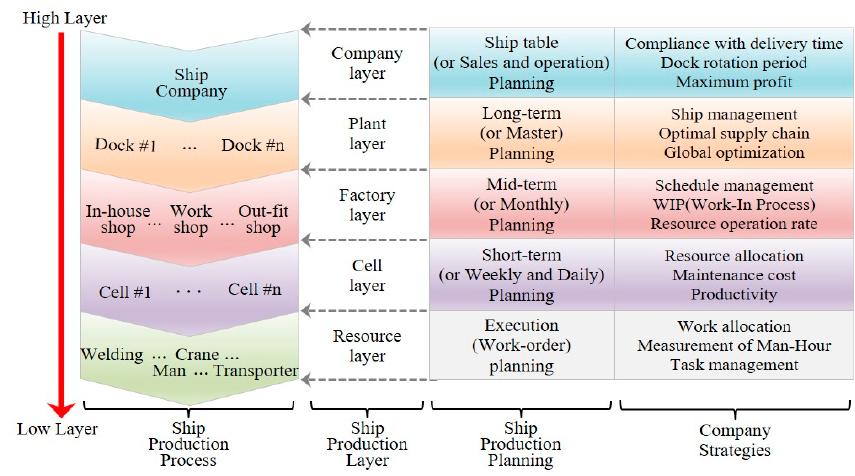
Figure 1. Hierarchy of the ship production process, production layer, production planning, and company strategies.